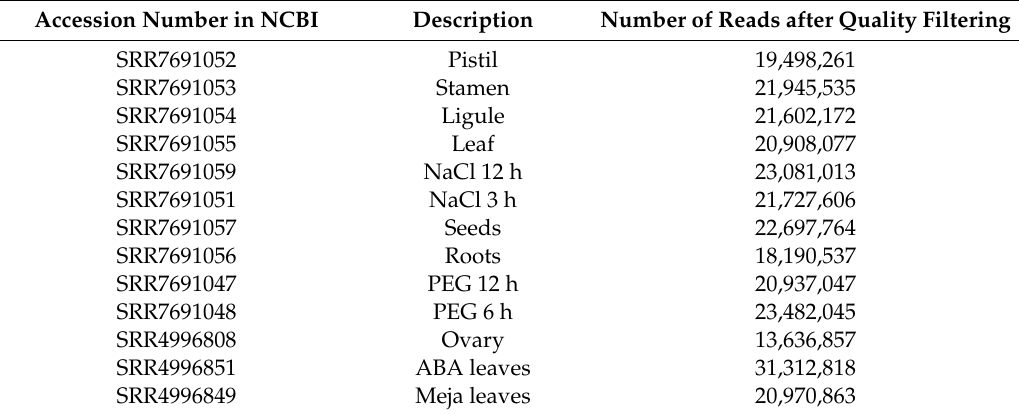
Figure 1. RNAseq-based identification of expressed LTR retrotransposons (exRTEs) in sunflower. ( A ): Scheme of the pipeline used in this study. ( B ): Venn diagram showing the number of exRTEs with detectable expression in stressed and non-stressed conditions. ( C ): Examples of RNAseq coverage plots for two exRTEs with distinct patterns of expression. ( D ): RT-PCR showing the expression of selected exRTEs in five-day-old seedlings. Table 1. NCBI accession numbers of RNAseq read archives used in this